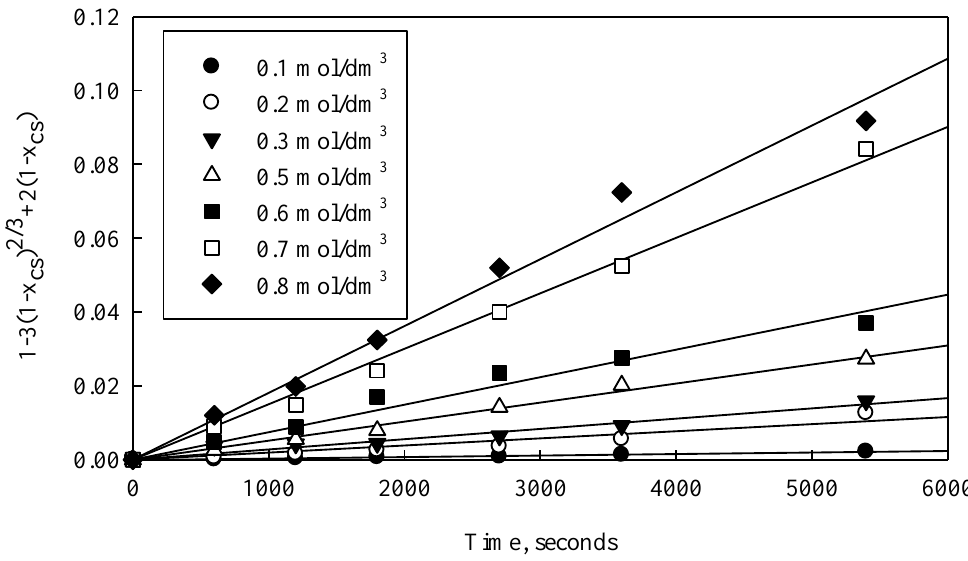
Figure 12. Leaching kinetics of converter slag using the data in Figure 6.